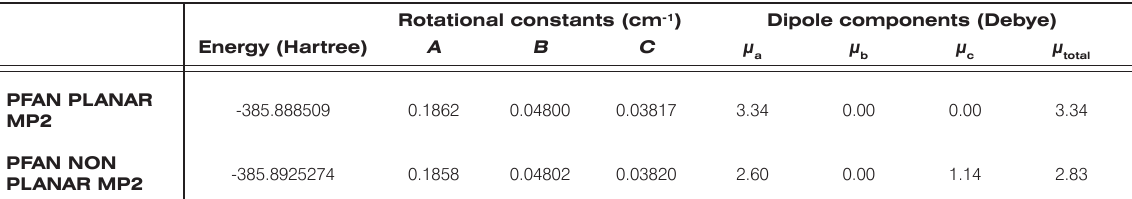
(Fig. 3 , Table 1 ). Both structures have a plane of